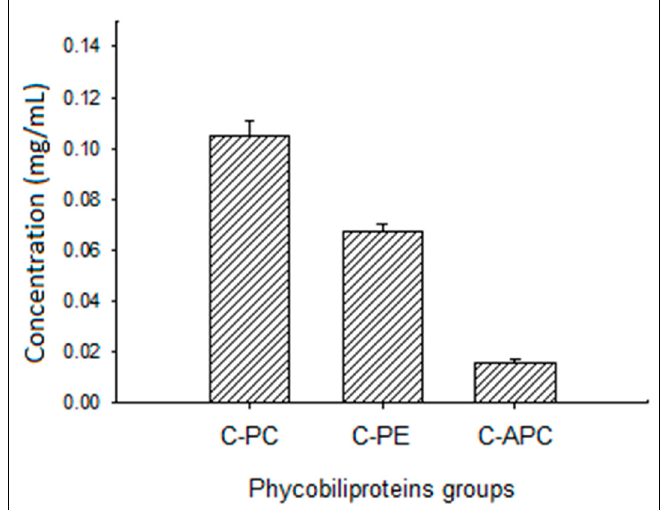
Figure 1. Cyanobacterial phycobiliproteins group concentration (mg/mL): phycocyanin (C-PC), phycoerythrin (C-PE), and allophycocyanin (C-APC).